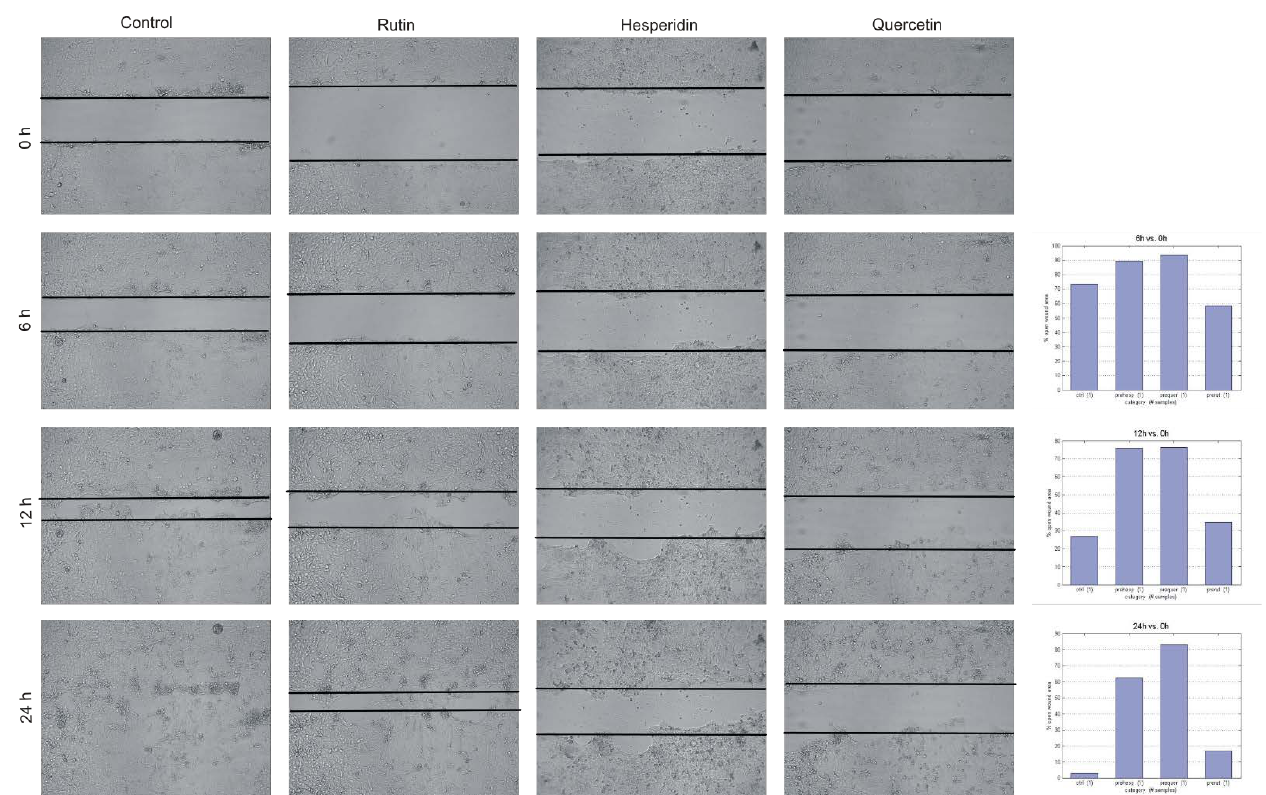
Figure 5. Pre-incubated Detroit 562 cells with flavonoids. Results of wound healing assay revealed arrest assay and pre- incubated Detroit 562 cells were similar compared to a standard experiment. Quercetin and Hesperidin at concentrations of ¼ IC 50 inhibited Detroit SCC 562 cells’ migration as after 24 h the gap/wound was still apparent, compared to control. Hesperidin revealed lesser effect on Detroit 562 cell migration inhibition compared to Que. Que and Hes treatment for 12 h and a dose of ¼ IC 50 demonstrated that the wound area remained almost unchanged over time.